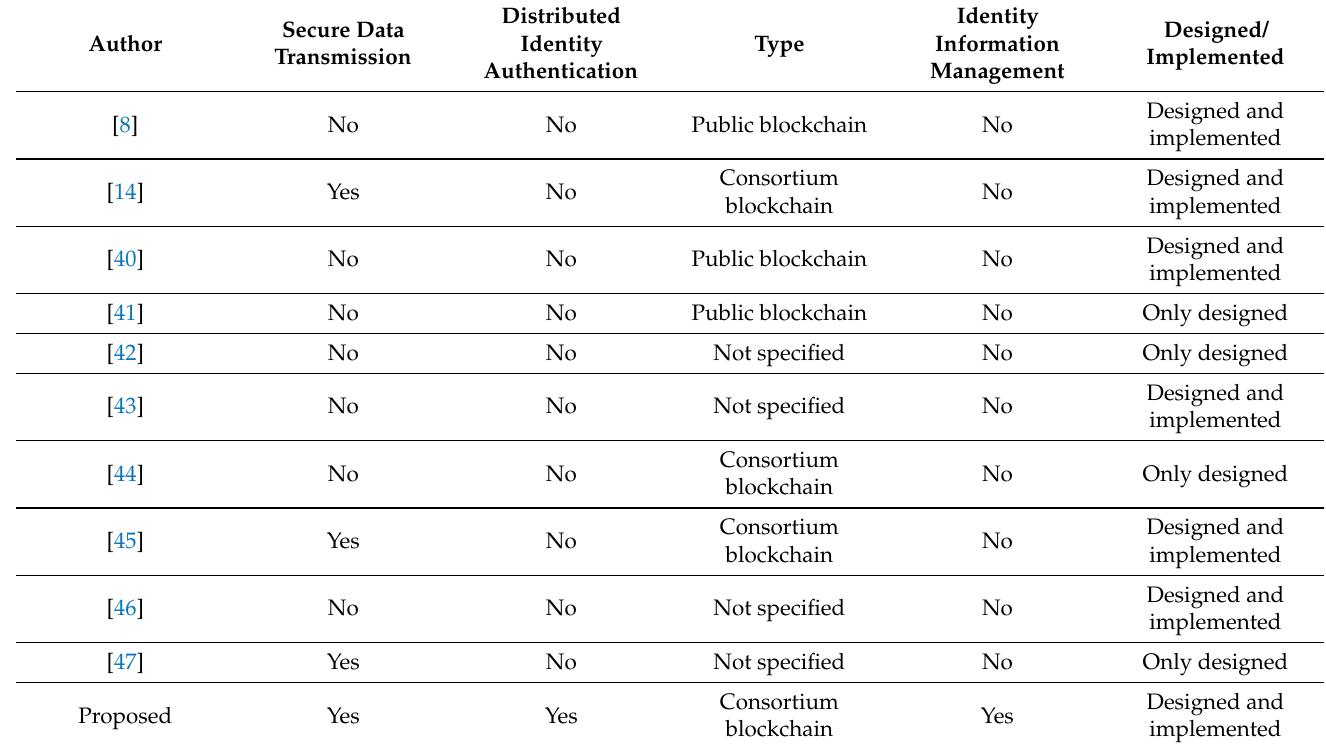
Table 1. Summary of literature